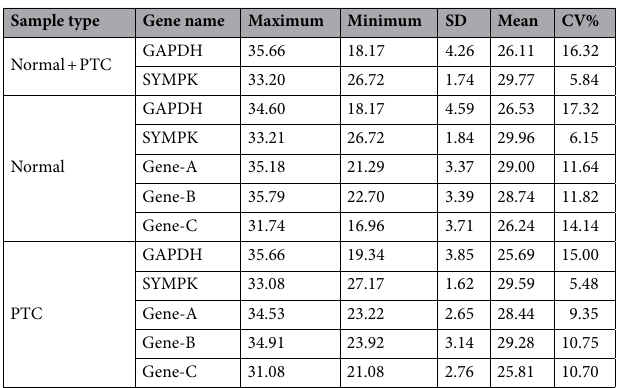
Table 1. Statistics for laboratory-collected RT-qPCR data. For each target and reference genes, statistical parameters from laboratory experiments such as maximum, minimum, SD, mean and CV% are listed. GAPDH has the highest SD and CV% values in both PTC and adjacent normal tissues,while SYMPK has the lowest. SD standard deviation, CV correlation of variation.